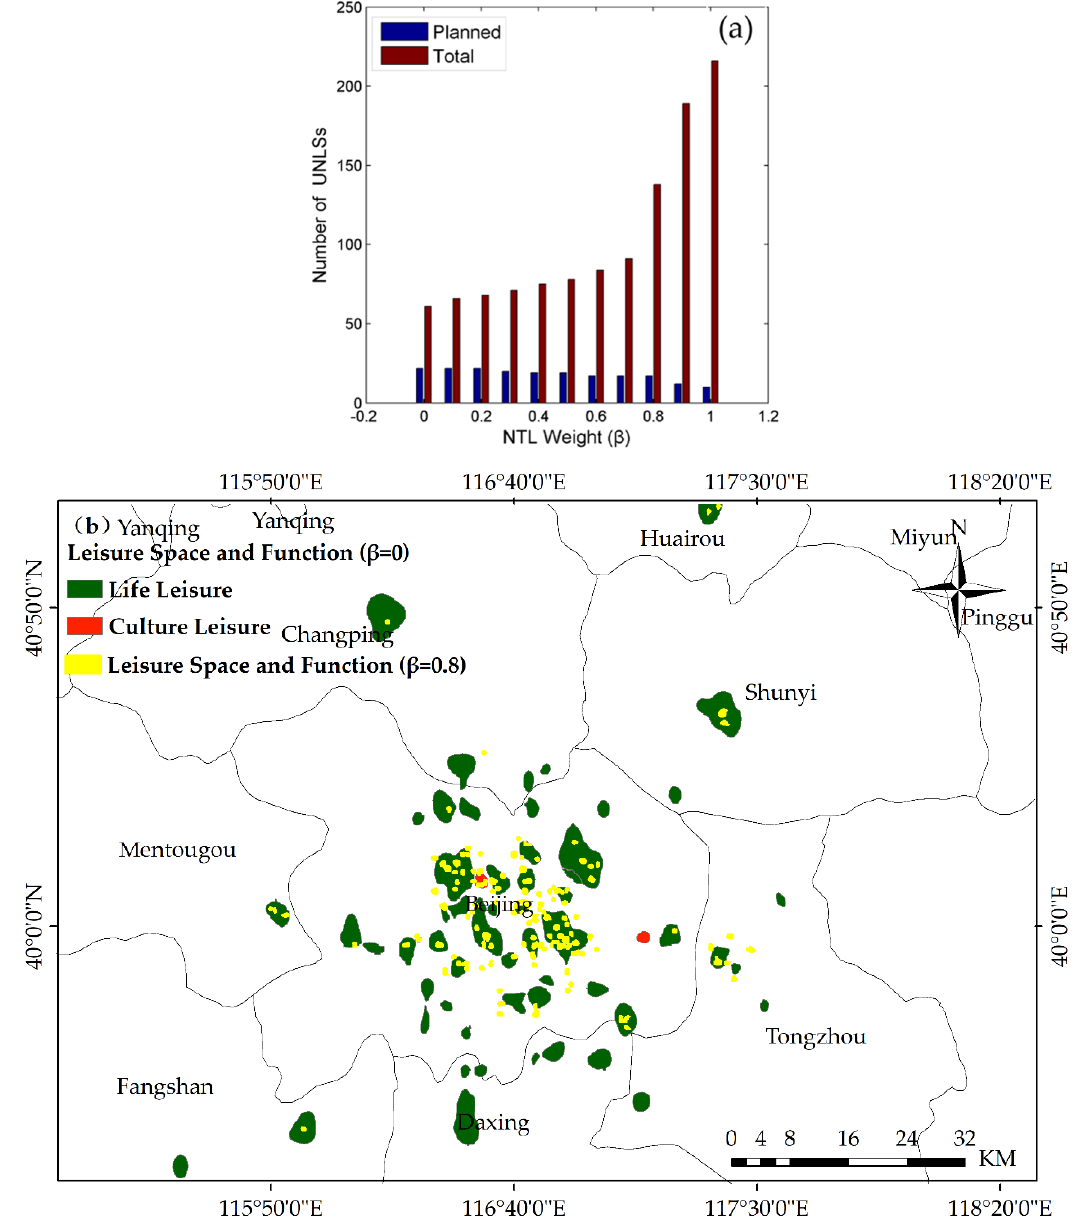
Figure 9. ( a ) Sensitivity of the detected UNLSs to the weight coe ffi cient of β . ( b ) Distribution of the UNLSs in Beijing when β = 0 .